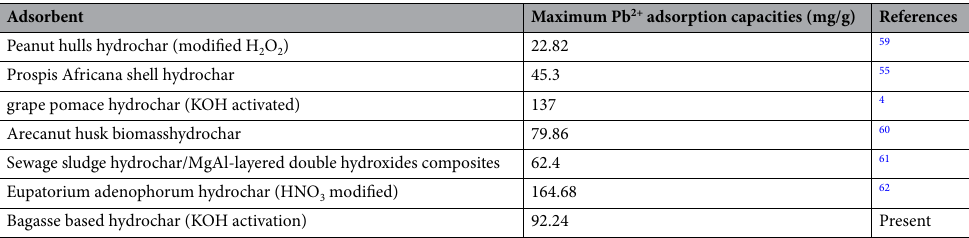
Table 5. Comparison of Pb 2+ adsorption capacities among other HC-based adsorbents from other studies and the present study .